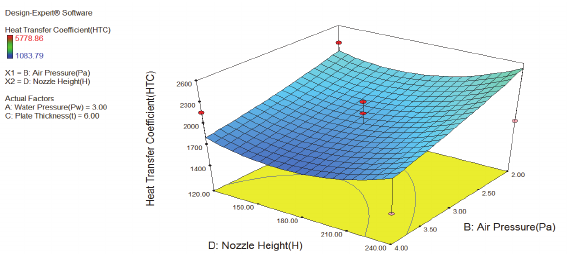
Fig. 6. Variation of HTC with respect to nozzle height and air pressure